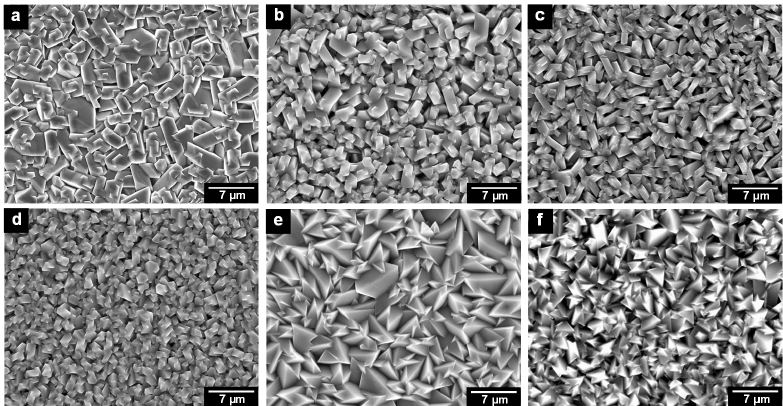
Figure 5. Scanning electron microscopy (SEM) images of the surface of magnetite films on carbon steel substrates with different roughnesses and agitation speeds at the − 1.05 V SCE in Fe(III)–TEA solution at 80 °C: ( a ) #80 grit, ( b ) #220 grit, ( c ) #600 grit, ( d ) #2000 grit, ( e ) #600 grit + stirring 900 rpm, and ( f ) #600 grit + stirring 900 rpm (deposition time: 700 s).